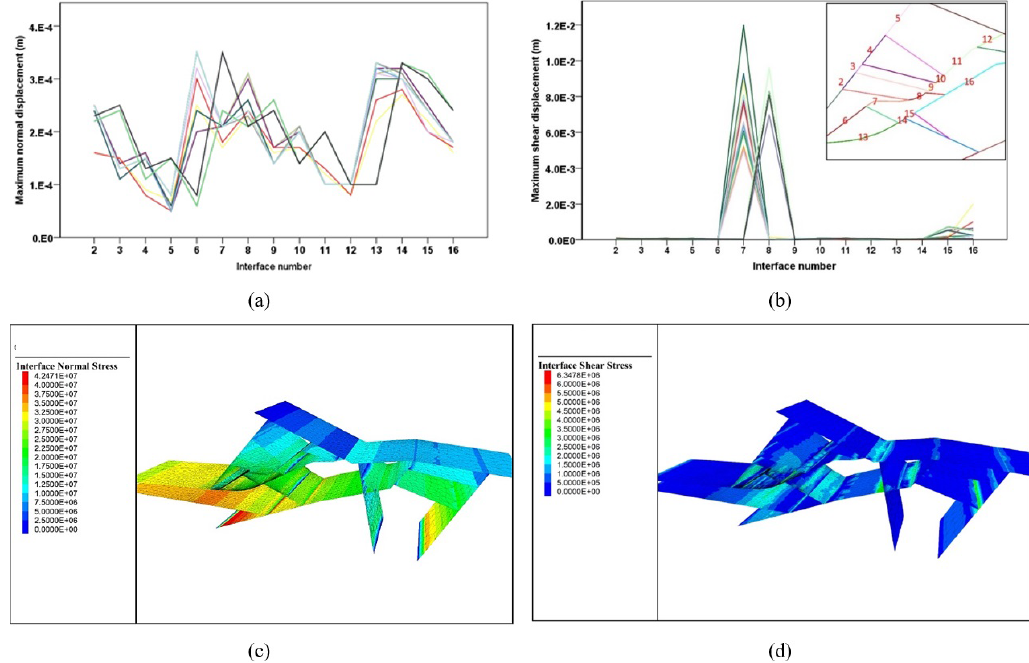
Figure 4. (a) Maximum normal displacement (m) when the friction at the faults was 10 ◦ , (b) maximum shear displacement (m) when the fault friction was 10 ◦ , (c) interface normal stress (Pa) when the up-to-down excavation case was considered and when Young’s modulus was minimum with the value of friction along the faults of 10 ◦ , and (d) interface shear stress (Pa) for the up-to-down excavation case when the value of Young’s modulus was minimum and the value of friction at the faults was 10 ◦